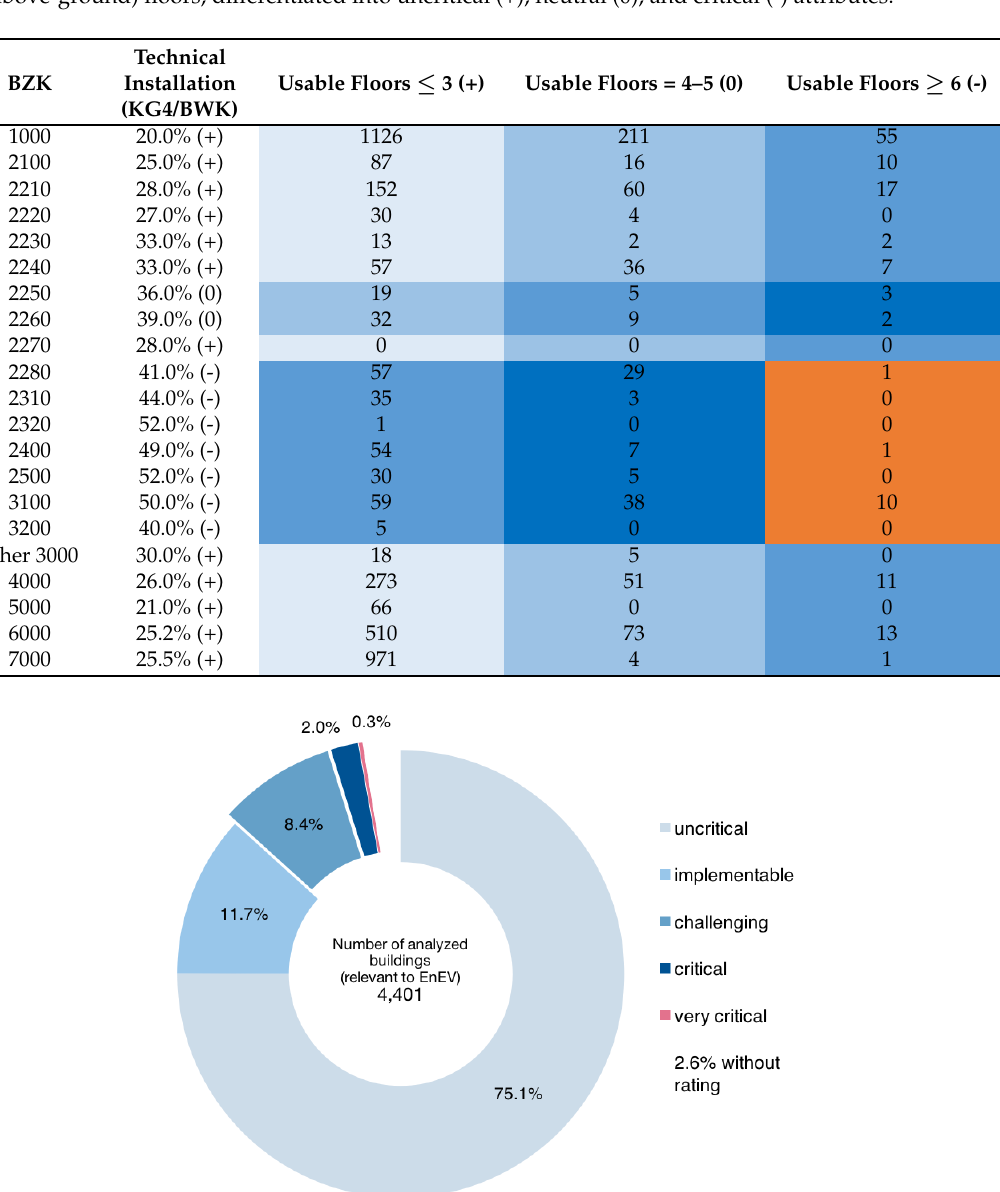
Table 5. Data analysis (number of buildings) of the property portfolio of Bavaria (data from [10]) using the criteria degree of technical installation (KG4/BWK) (data from [15,16]) and the number of usable (above-ground) floors, differentiated into uncritical (+), neutral (0), and critical (-) attributes.